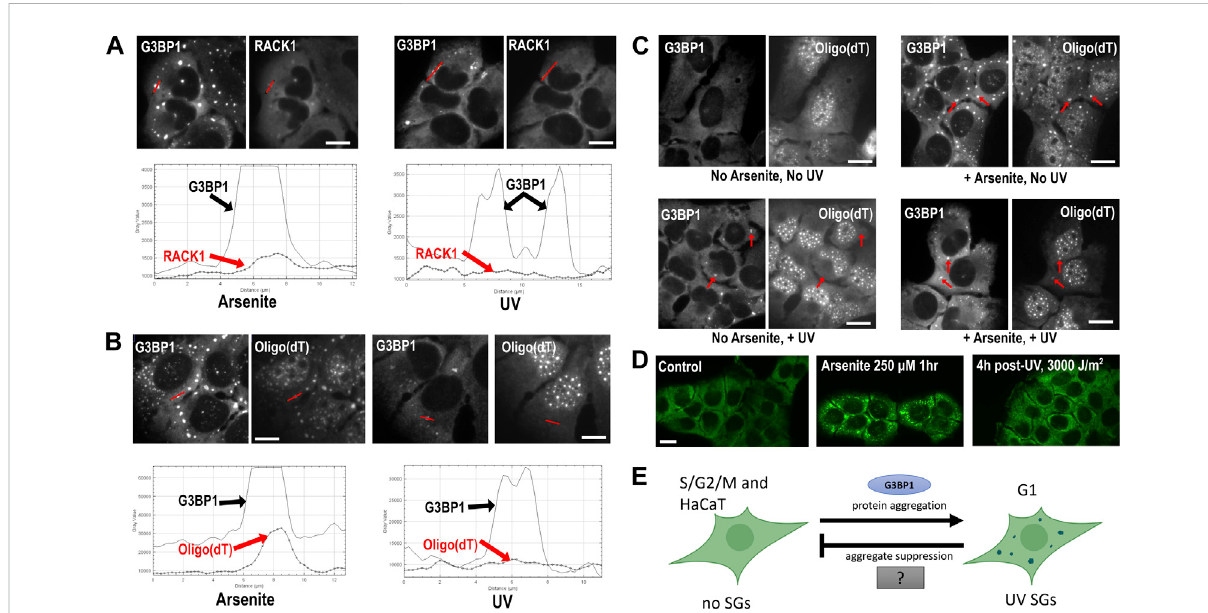
FIGURE 1 Composition and formation of UV SGs. (A) RACK1 does not localize to UV-induced SGs. U2OS treated with arsenite (500 μ M, left panels) or UV (15 J/m 2 ,then assayedat4 hpost-UV,rightpanels)andco-stainedwithantibodiestoG3BP1 andRACK1. Pro fi leintensity plots overthered linefrom each image were compiled using ImageJ. (B) U2OS treated with arsenite (500 μ M, left panels) or UV (15 J/m 2 , then assayed at 4 h post-UV, right panels) and co-stained with antibodies to G3BP1 and Oligo (dT). Pro fi le intensity plots over the red line from each image were compiled using ImageJ. (C) Poly(A)+ RNA SGs can form after UV treatment. U2OS were untreated or treated with UV (15 J/m 2 ) for 3 h, then arsenite (500 µM) was added where indicated for a 1 h, then cells were fi xed and co-stained with antibodies to G3BP1 and Oligo (dT) FISH. Red arrows point to prominent SGs in each treatment condition. (D) HaCaT cells do not form UV SGs. HaCaT cells were exposed to arsenite 250 µM for 1 h, or exposed to 3,000 J/ m 2 UV (4 h post-exposure), then stained with antibody for G3BP1 to assess SG formation. Detailed methods for all panels are available as Supplementary Material online. (E) A model for UV SG suppression. See Discussion section for